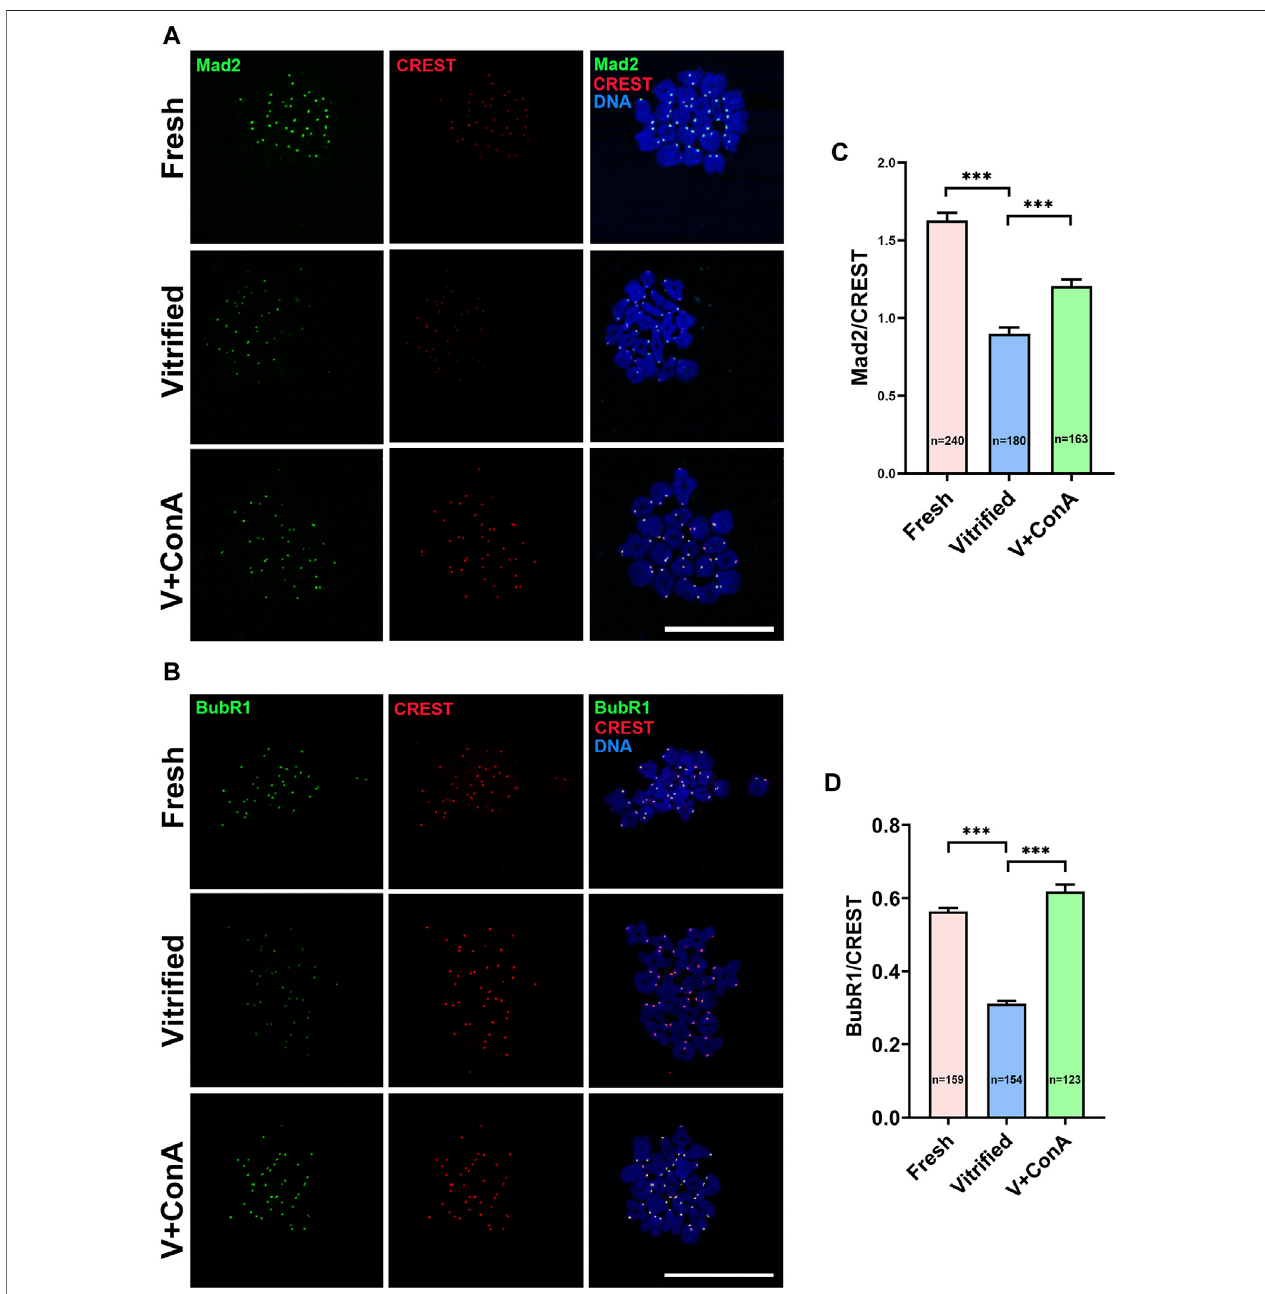
FIGURE9| Increasingcorticaltensionstrengthened SAC activity. (A) ThelocalizationofMad2 at prometaphase Istage infresh,vitri fi ed,and V+ConAoocytes.At 3 h after germinal vesicle breakdown (GVBD), oocytes were immunostained for Mad2, CREST, and DNA (DAPI). Scale bar = 50 μ m. (B) The localization of BubR1 at prometaphase I stage in the fresh, vitri fi ed, and V + 10 μ g/ml ConA oocytes. At 3 h after GVBD, oocytes were stained for BubR1, CREST, and DNA (DAPI). Scale bar = 50 μ m. (C) The relative fl uorescence intensity of Mad2 to CREST was measured in fresh ( n = 240), vitri fi ed ( n = 180), and V + ConA ( n = 163) groups. The signal intensity of Mad2 was normalized with that of CREST. (D) The relative fl uorescence intensity of BubR1 to CREST was measured in the fresh ( n = 159), vitri fi ed ( n = 154), and V + ConA ( n = 123) groups. The signal intensity of BubR1 was normalized with that of CREST. Data were presented as mean percentage (mean ± SEM) of at least three independent experiments. * p < 0.05, ** p < 0.01, *** p < 0.001.